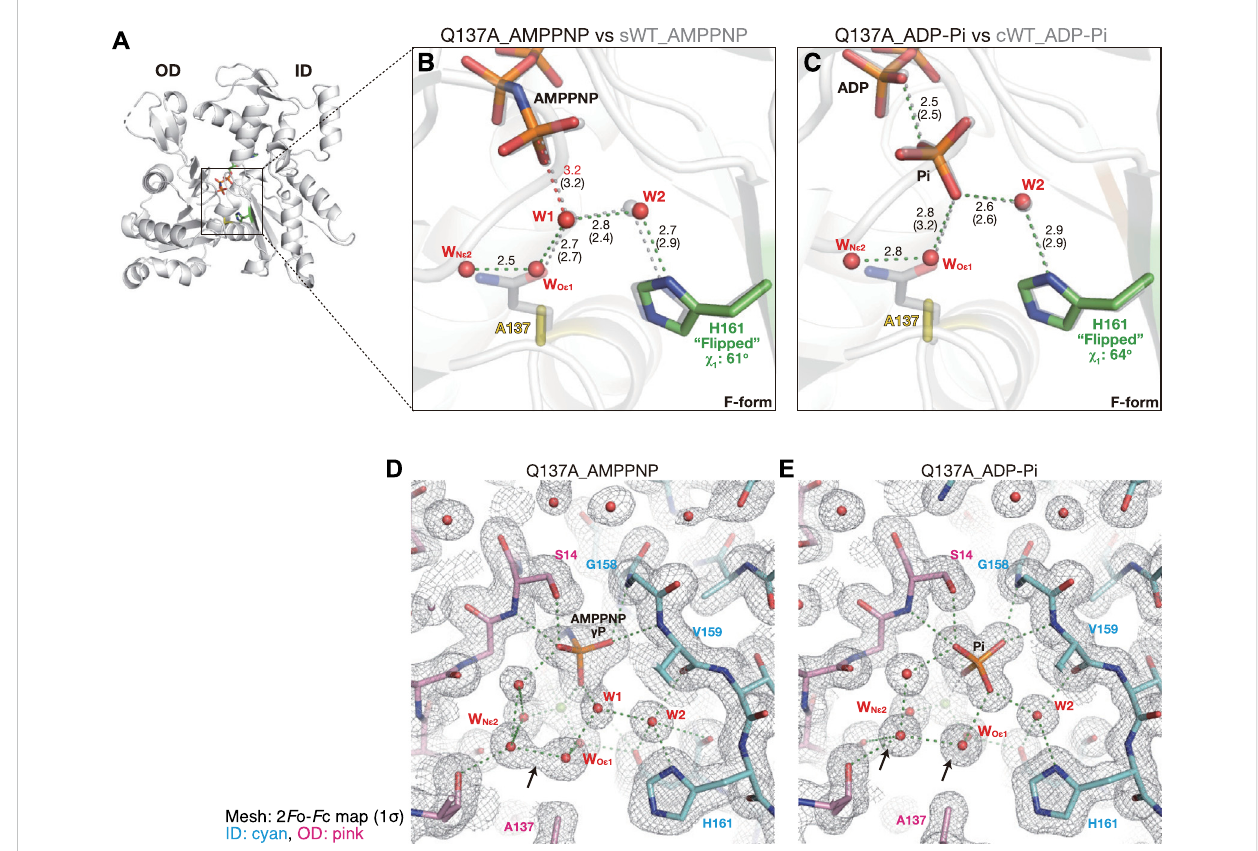
FIGURE 7 Structures of Q137A. (A) Overall structure of Q137A_AMPPNP (back view). (B – C) Close-up views of the active site of Q137A_AMPPNP (B) and Q137A_ADP-P i (C) .Forcomparison,nucleotides,keyresidues,andwatermoleculesfromsWT_AMPPNP (B) orcWT_ADP-P i (C) areshownbytransparent gray sticks/spheres. W O ε 1 and W N ε 2 are water molecules replacing O ε 1 and N ε 2 of Q137 in the wild-type actins, respectively. Distances (Å) between key atoms are indicated (corresponding distances in the reference structure are in parentheses). (D – E) 2 F o- F c electron density map contoured at 1 σ with P γ /P i in thecenter ofthe panel. The ID and ODof actin are colored cyan and pink, respectively.In Q137A_AMPPNP (D) ,W O ε 1 and W N ε 2 are only 2.5 Å apart and in a continuous density (arrow). In Q137A_ADP-P i (E) , the two water molecules are separated at 2.8 Å with distinct densities (arrows), likely due to the inversion of the P i con fi guration that leads to a rearrangement of the surrounding water